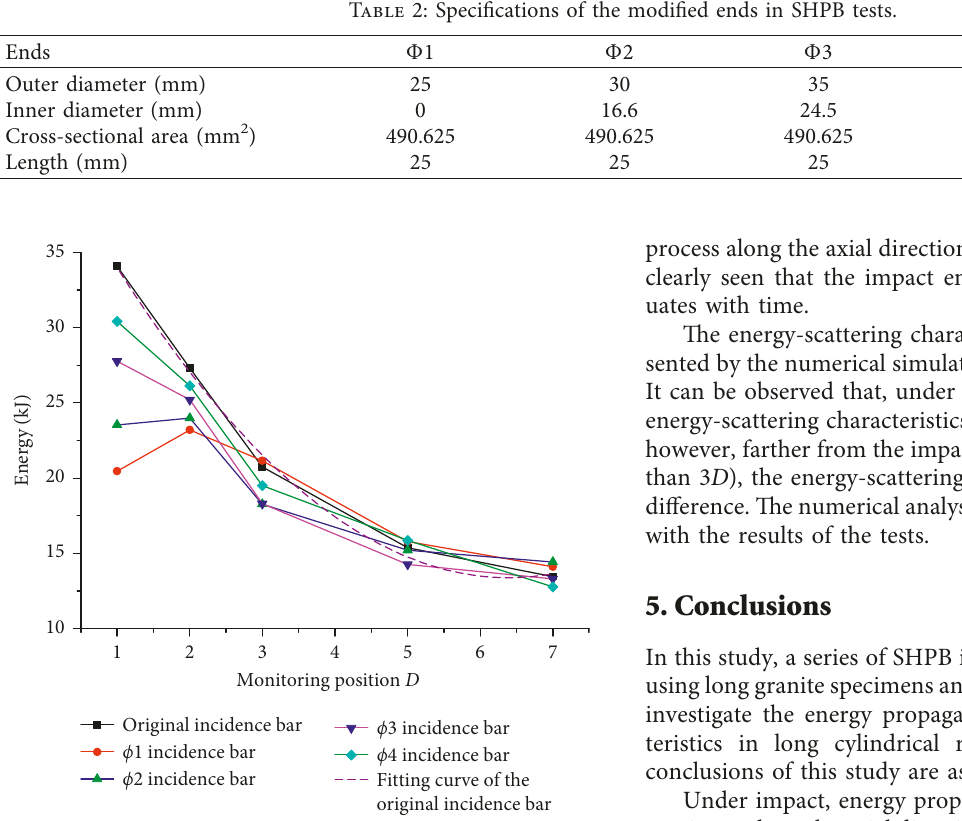
Figure 10: Energy scattering with different incidence bar